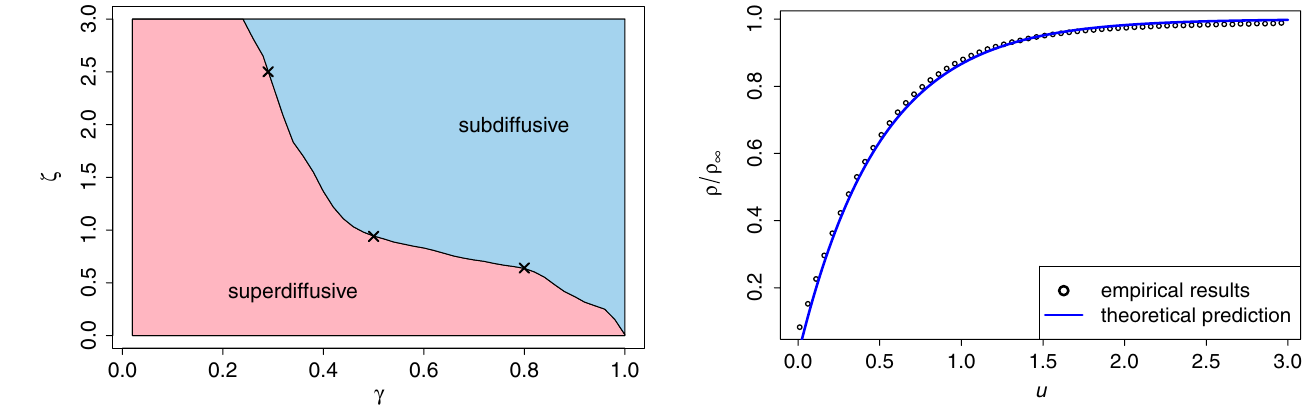
p ffiffiffiffiffiffiffiffiffiffiffiffiffiffiffiffi ¼ 0 : 49 , D= 2 (cid:5) 1